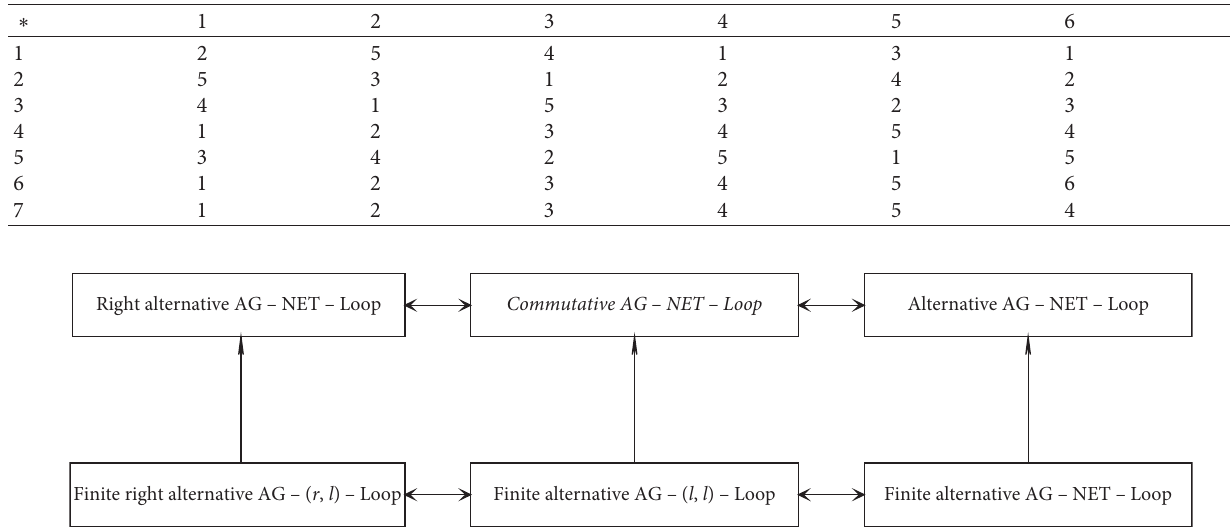
Table 11: Table of Example 11.